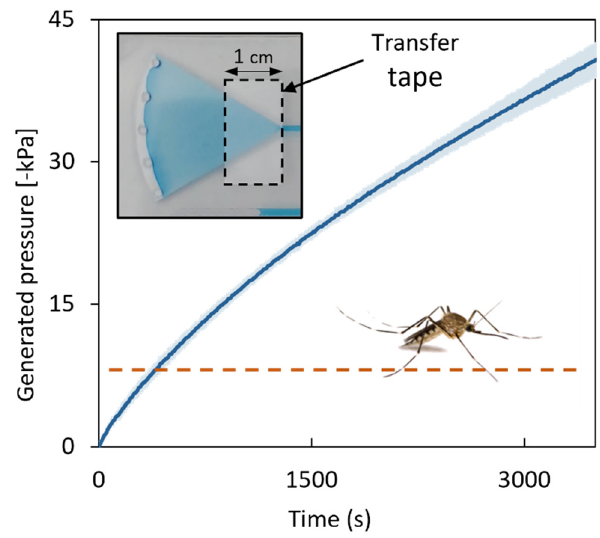
Figure 6. Average generated pressures by the SIMPLE chip reinforced by sealing the filter paper pump tip with transfer tape (see inset). The shaded area represents 1 standard deviation ( n = 4). The orange dashed line depicts the reference pressure difference as generated by a mosquito when pulling blood from skin capillaries.